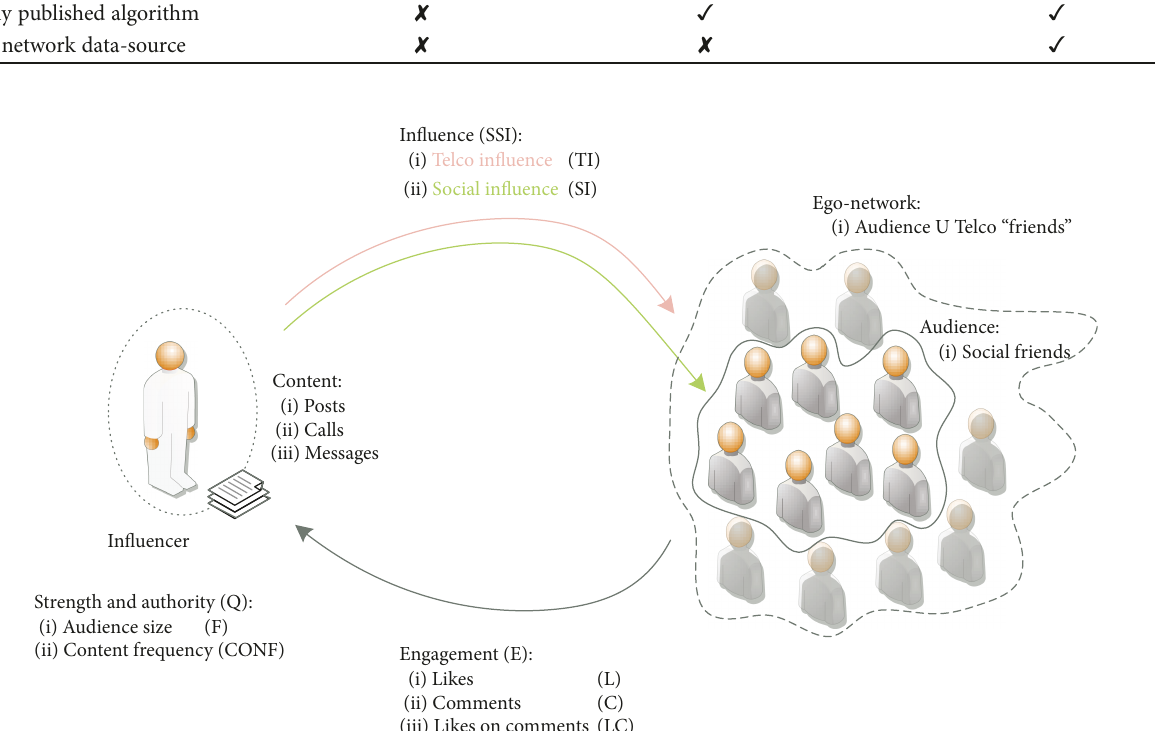
Figure 2: The SmartSocial In fl uence